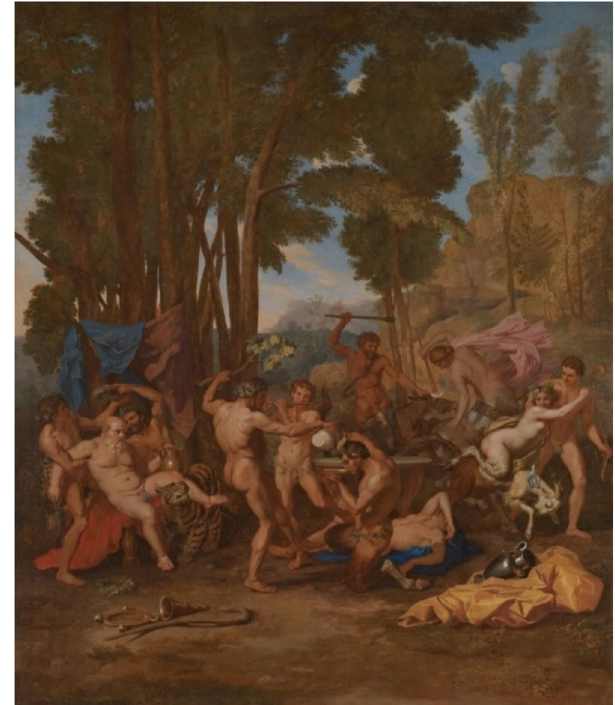
Figure 27: Poussin, The Triumph of Silenus , ca. 1637. National Gallery, London. Public